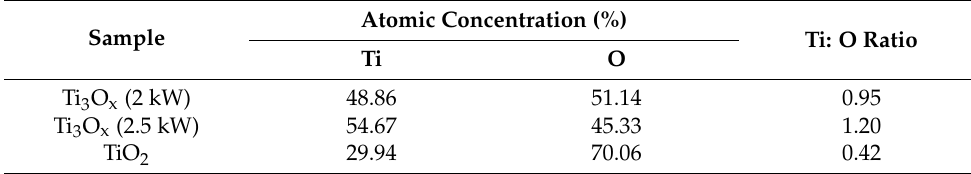
Table 1. Chemical composition of Ti 3 O x thin